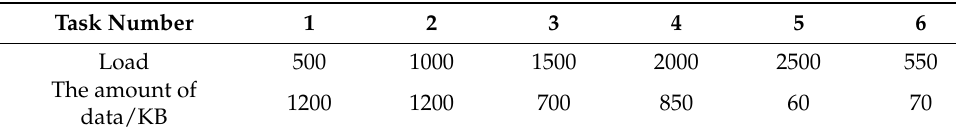
Table 2. Task load and data volume.